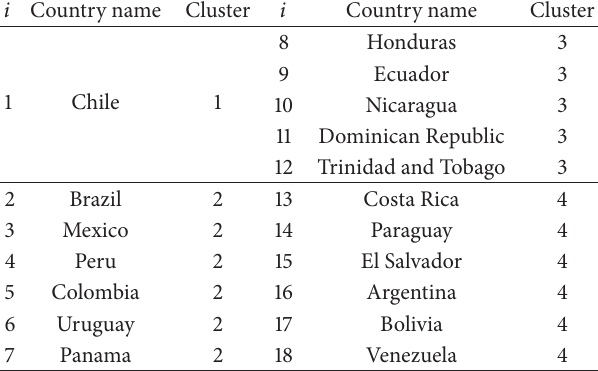
Table 1: Clustering obtained by non-hierarchical clustering tech-